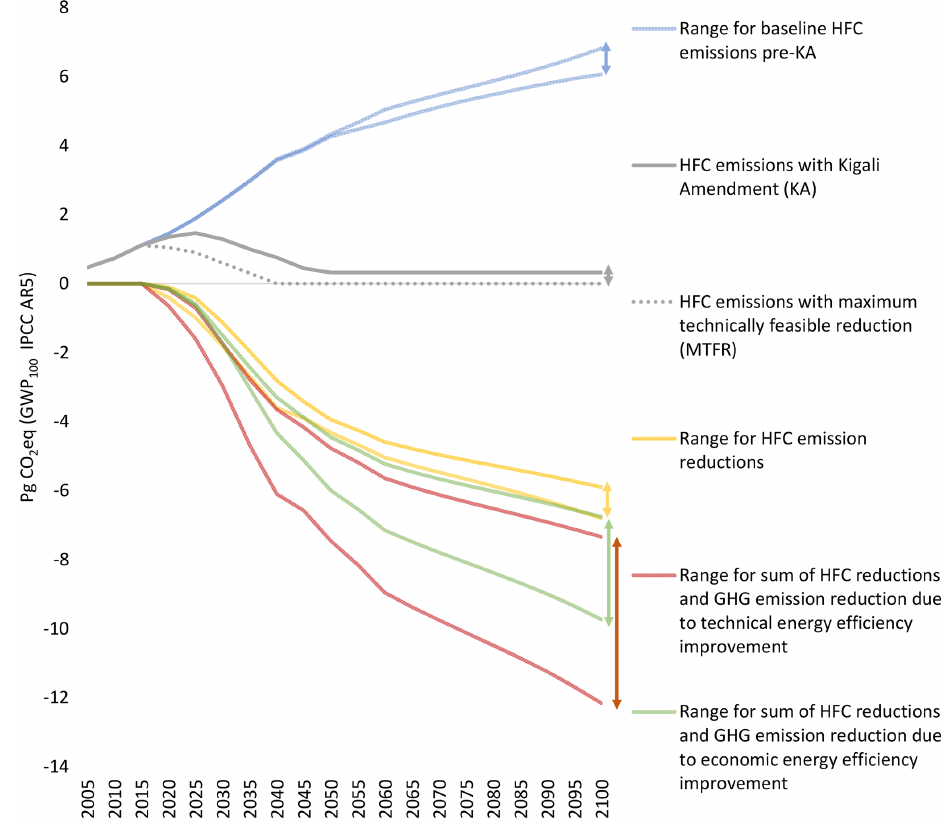
Figure 7. Full range of HFC emissions and mitigation potential under baselines and Kigali Amendment (KA) and maximum technically feasible reduction (MTFR) scenarios along with HFC and other greenhouse gas mitigation under technical and economic energy efficiency improvement scenarios analyzed in this